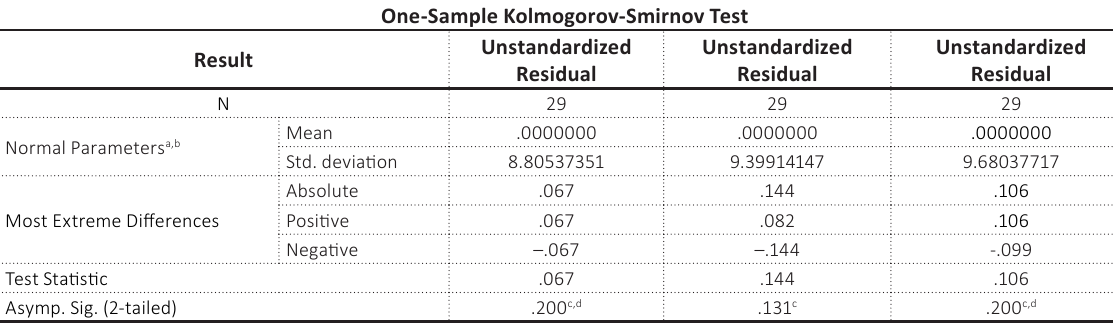
Table 6. Normality test for the 2 nd regression